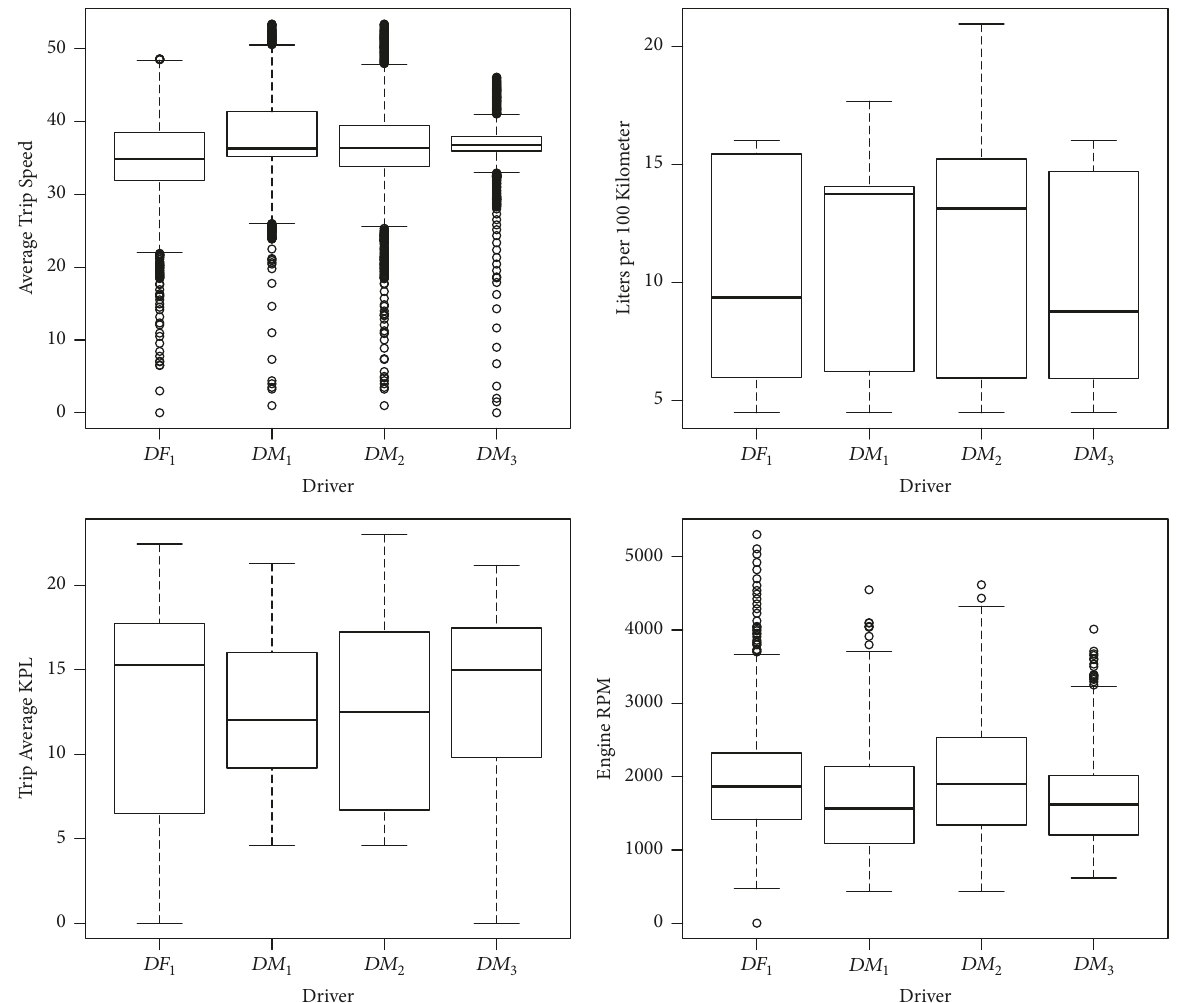
Figure 3: Box plots related to the distribution of the features Average Trip Speed, Liters Per 100 Kilometers, Trip Average KPL, and Engine RPM for the drivers 𝐷𝐹 1 , 𝐷𝑀 1 , 𝐷𝑀 2 , and 𝐷𝑀 3